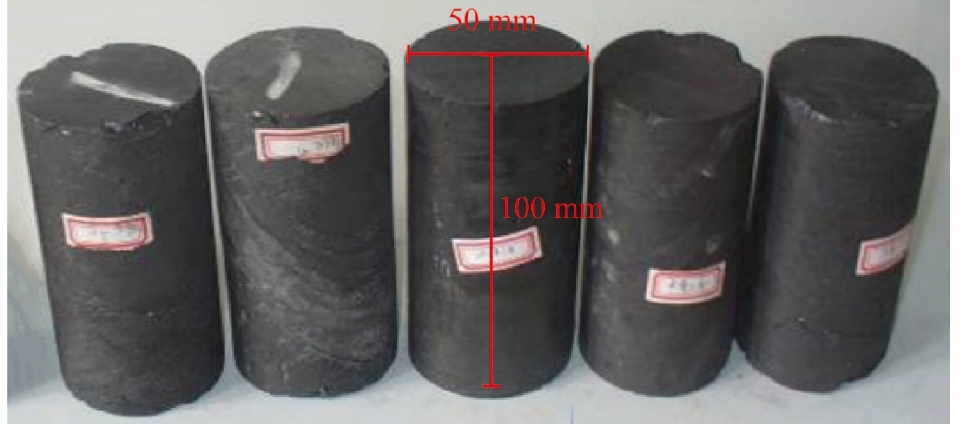
Figure 1. Picture of uniaxial compression sample.